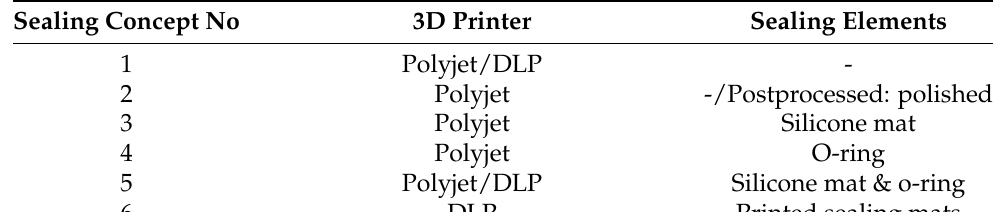
Table 1. List of tested sealing concepts.